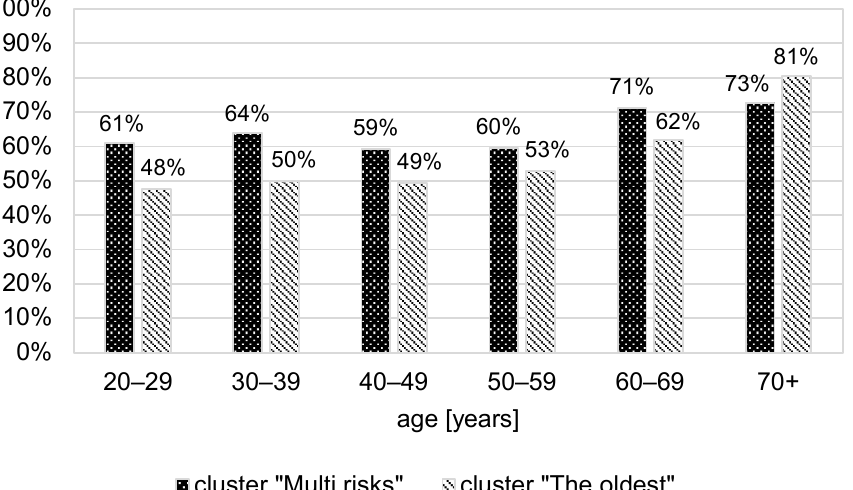
Figure 1. Percentage of people who do not participate in recreational physical activity in clusters “Multi risks” and “The oldest”, depending on their age.